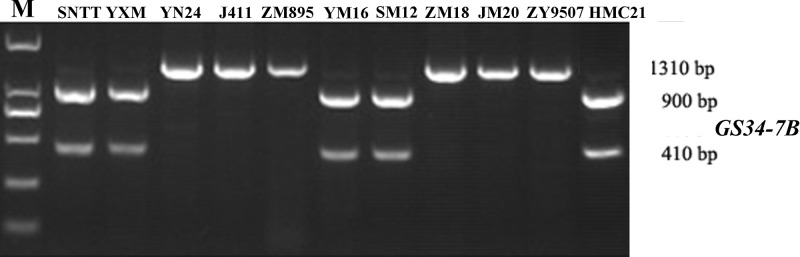
Different genotypes identified by the functional marker GS34-7B in different wheat varieties. Shown are: Suiningtuotuo (SNTT), Yangxiaomai (YXM), Yangnong 24 (YN24), Jing 411 (J411), Zhongmai 895 (ZM895), Yangmai 16 (YM16), Shimai12 (SM12), Zhongmai 18 (ZM18), Jimai 20 (JM20), Zhongyou 9507 (ZY9507), and Hongmangchun 21 (HMC21).